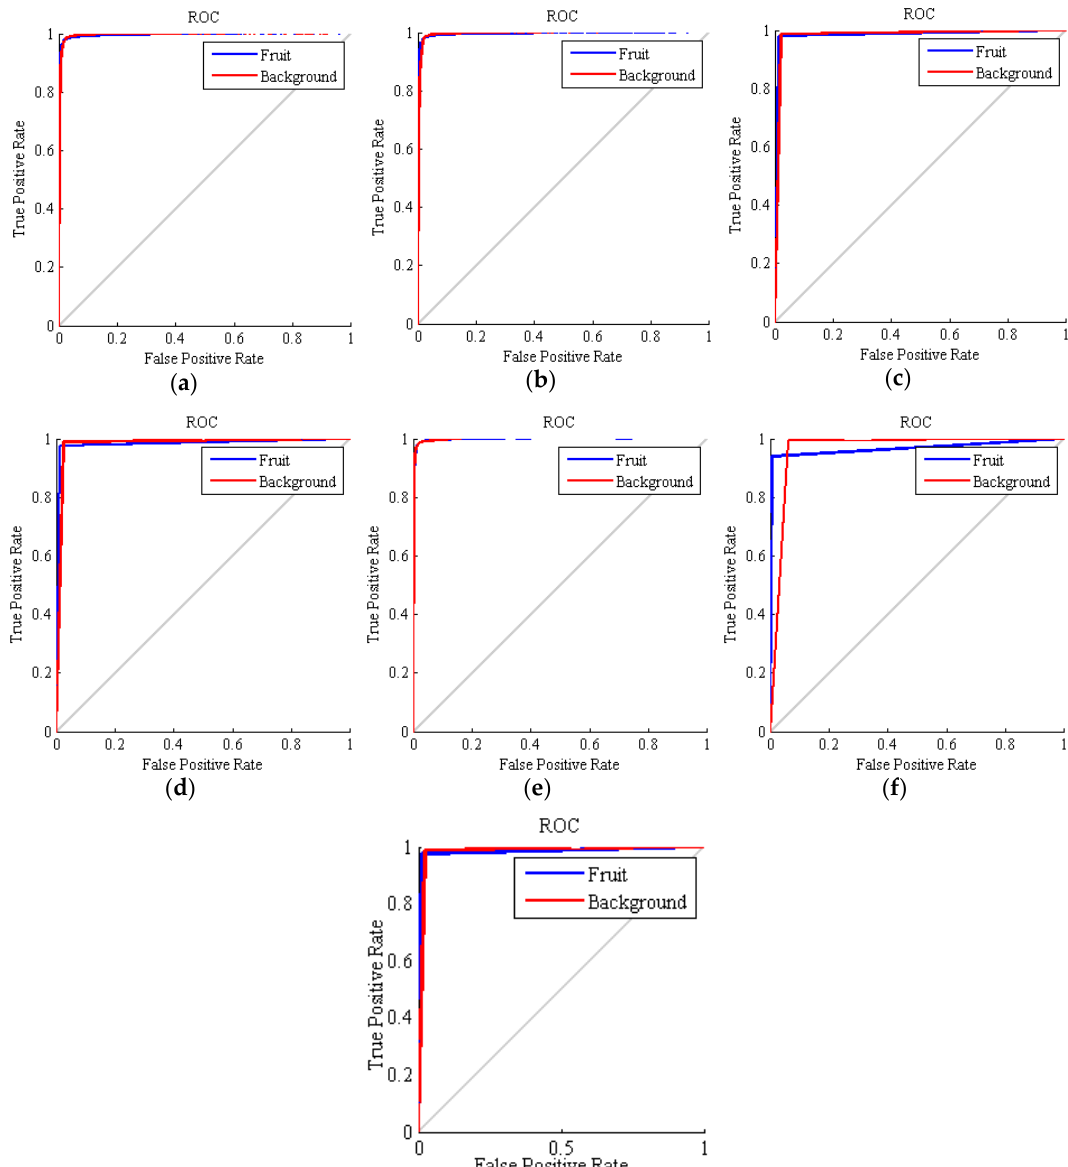
Figure 4. Receiver operating characteristic (ROC) curves obtained by the classifiers for the 275 executions. ( a ) hybrid ANN-ICA; ( b ) hybrid ANN-HS; ( c ) support vector machines (SVM); ( d ) k nearest neighbors (kNN); ( e ) linear discriminant analysis (LDA); ( f ) voting method with LDA; ( g ) voting method without LDA.